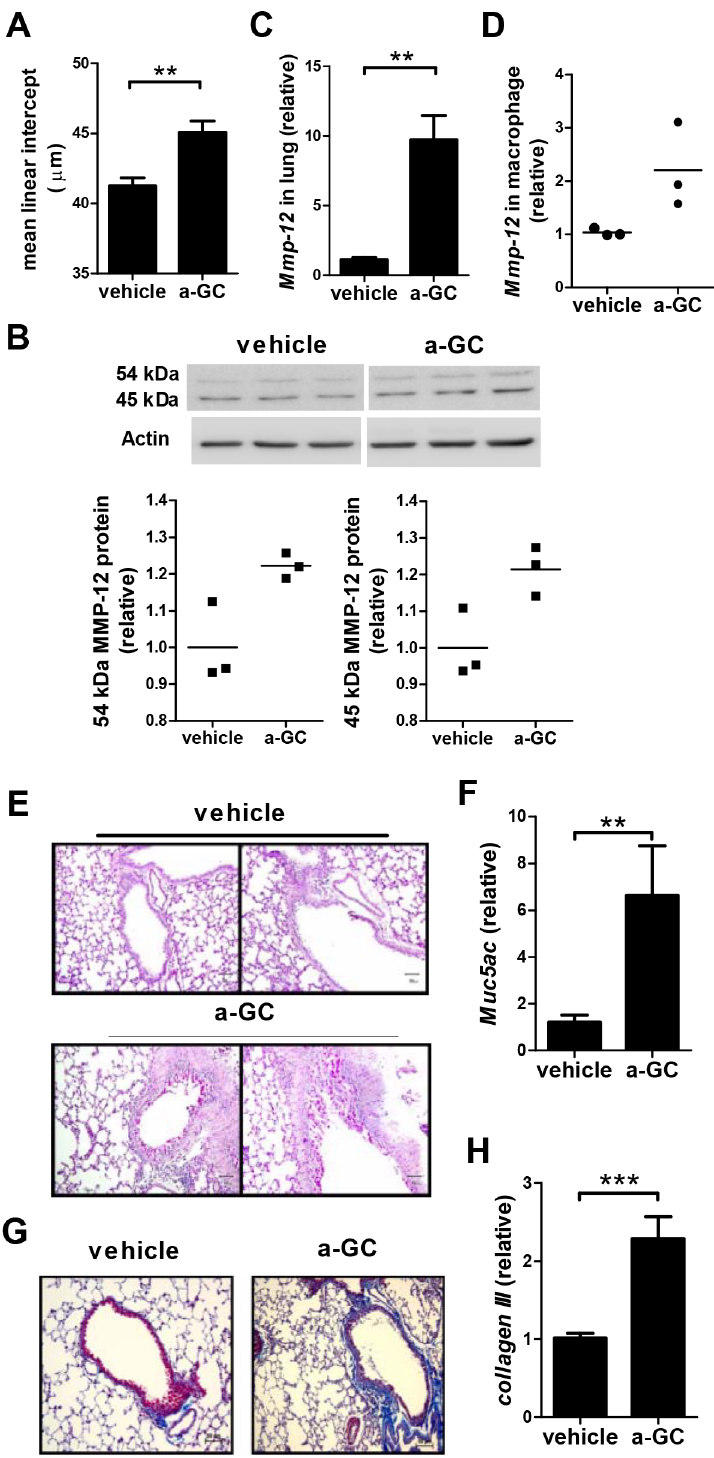
Fig 4. The presence of emphysema, mucus production and fibrosis in mice with repeated intranasal administration of α -GalCer. Mice were intranasally administered with α -GalCer once a week for 6 weeks and histopathological changes were examined 2 weeks after the last administration. (A) The mean linear intercept of the alveolar septa was measured. (B) The upper panels show the western blot results of 54 kDa and 45 kDa MMP12 protein expression in the lung and summarized in the lower panels. Actin was used as an internal control. Each symbol represents an individual mouse and the horizontal lines represent the means. (C) The expression of Mmp-12 in lung tissues was analyzed by quantitative RT-PCR. (D) The expression of Mmp-12 in lung macrophages was measured by quantitative RT-PCR. Each symbol represents cells